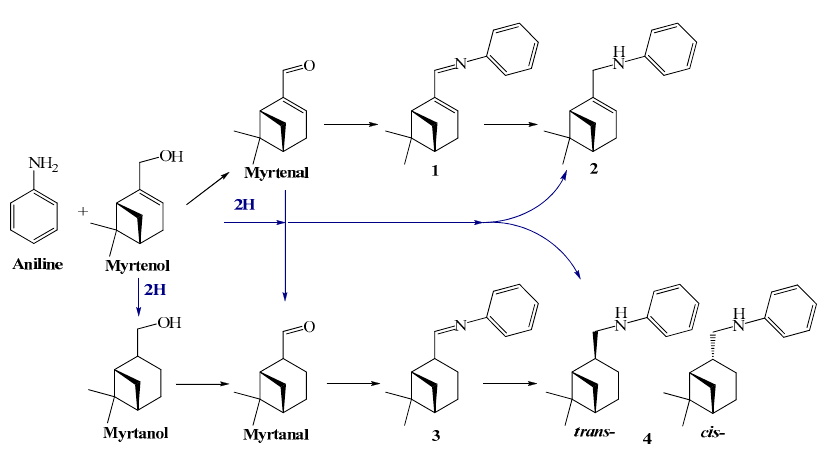
Figure 23. Myrtenol amination with aniline over Au catalysts. Reprinted from [138] with permission from Elsevier.